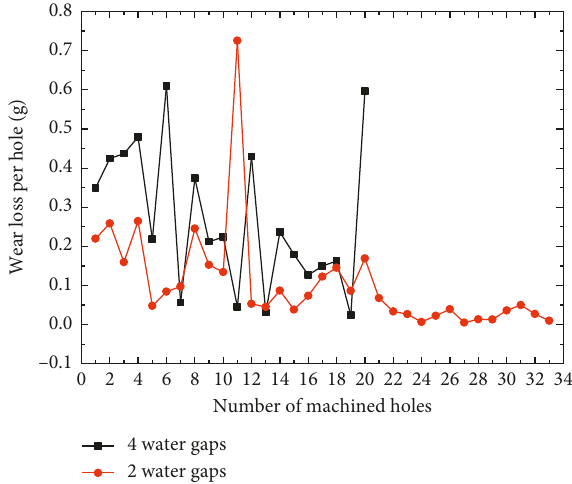
Figure 6: Wear rates of the bit under different number of water